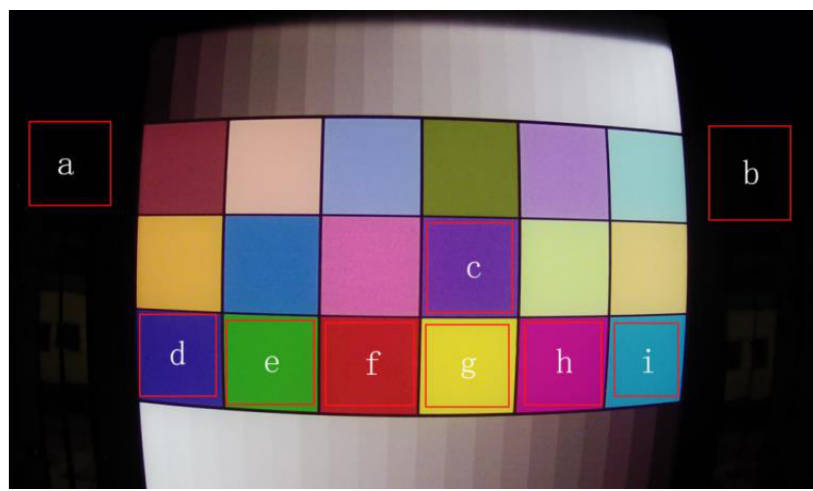
Figure 2. Region division of color image. a and b belong to the dark area, c-i belong to the color area.